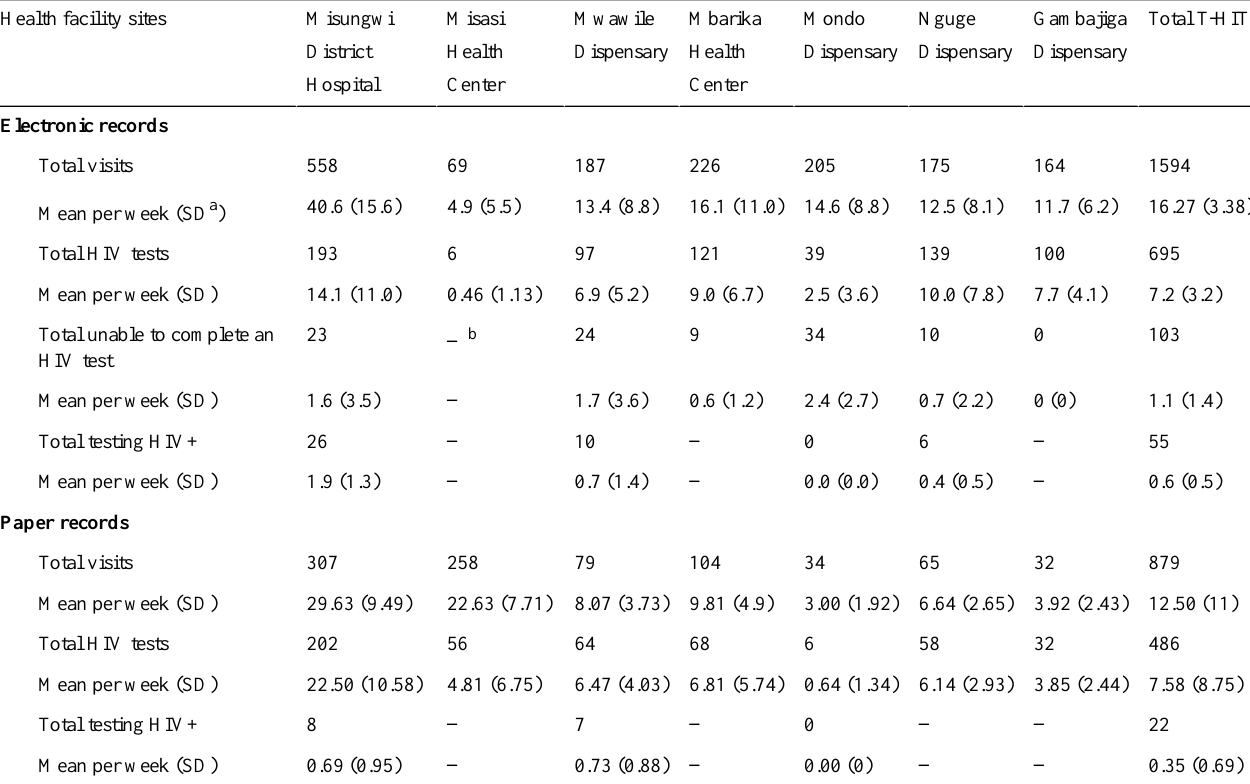
Table 1. Antenatal visit information at Tanzania Health Information Technology (T-HIT) health facility sites.